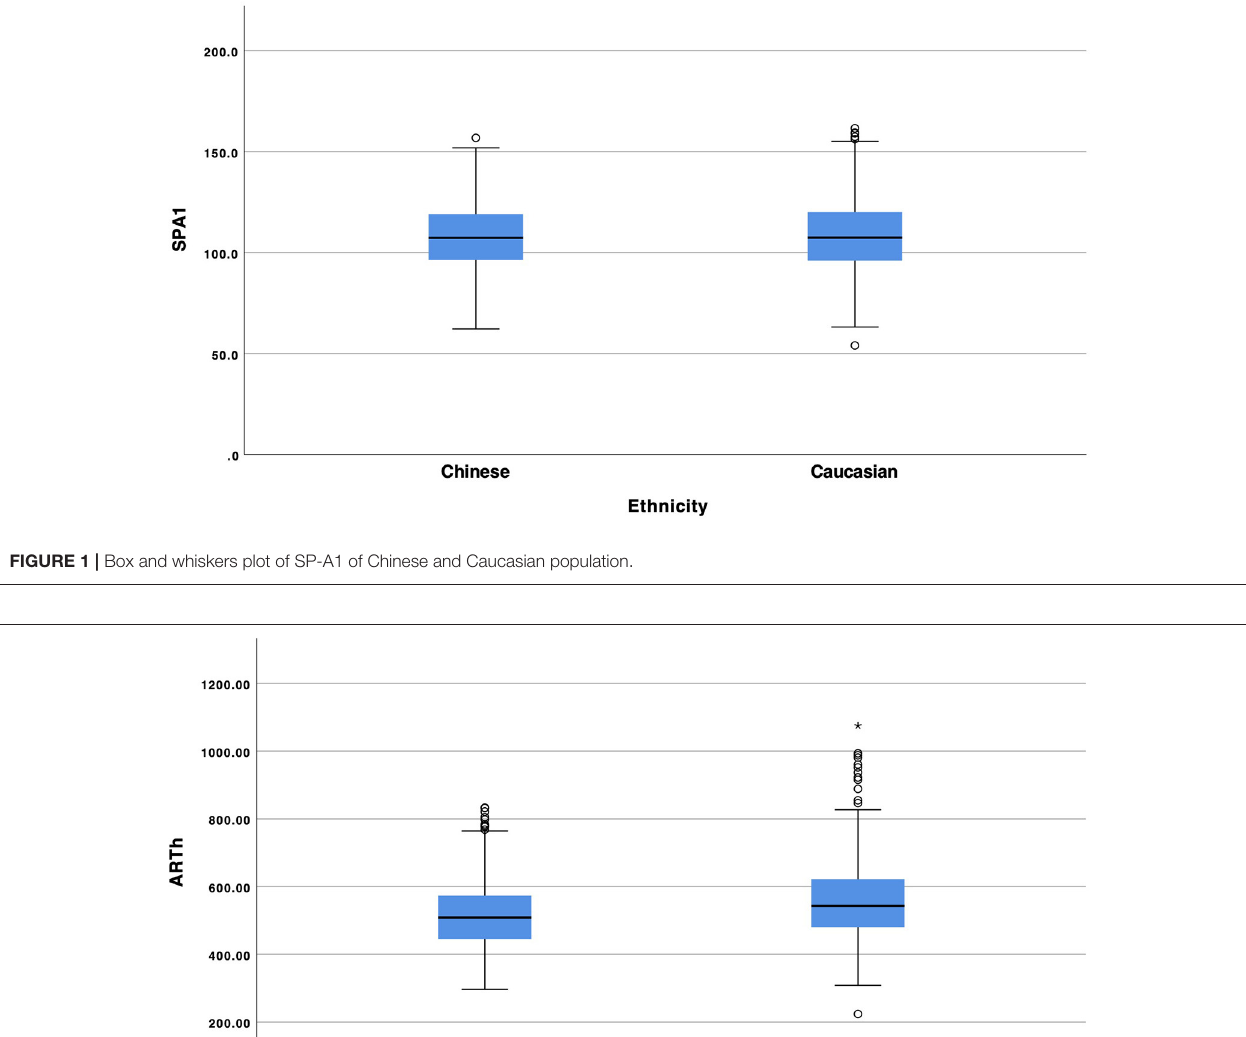
= 0.184) were not significantly different between the